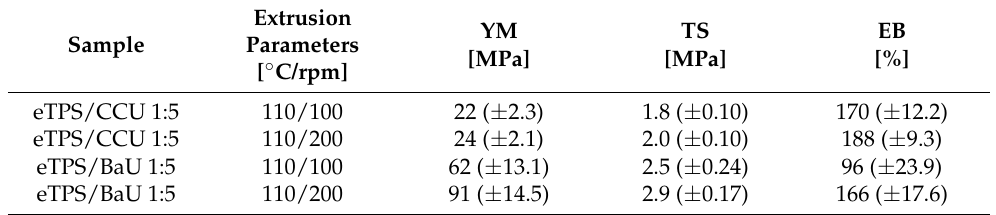
Table 3. Mechanical properties of TPS films obtained via extrusion and thermocompression (test 2).